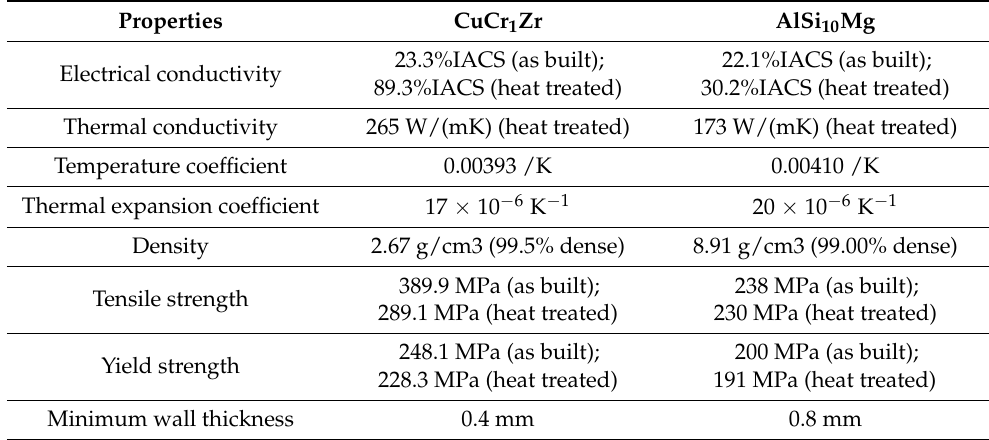
Table 1. Electrical, thermal, mechanical properties of copper and aluminum alloys [38].